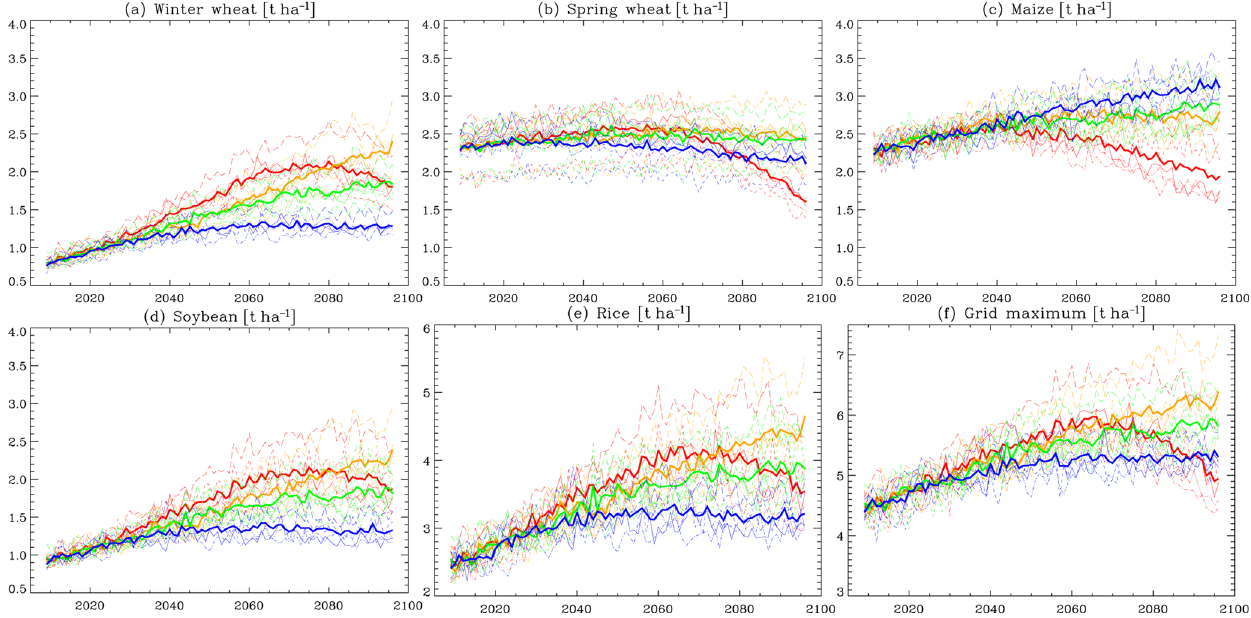
Figure 11. Time series of changes in crop yield (unit: tha − 1 ) based on the forcings of the five climate models. Results shown are for (a) winter wheat, (b) spring wheat, (c) maize, (d) soybean, (e) rice, and (f) grid maximum value for the five crop types. Thin curves indicate the global average of results for each of the five climate model forcings. Thick curves show the overall average of results based on the five forcings. The colors indicate RCP2.6 (blue), RCP4.5 (green), RCP6.0 (orange), and RCP8.5